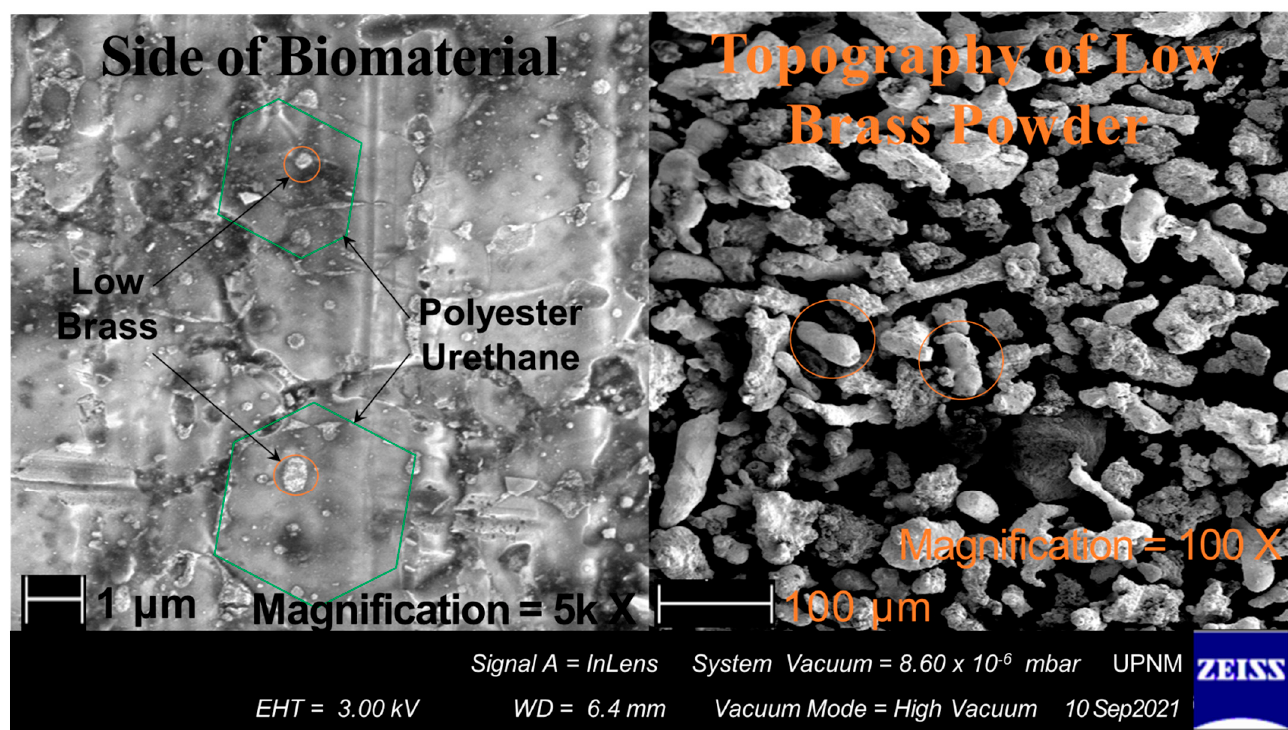
Figure 2. Composition structures of biomaterial and topography of low brass powder.